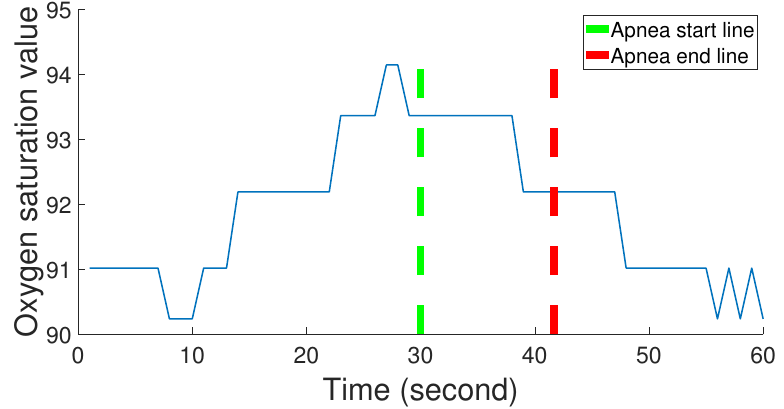
Figure 2. One apnea event duration in SaO 2 signals; the duration is between the apnea start line and the apnea end